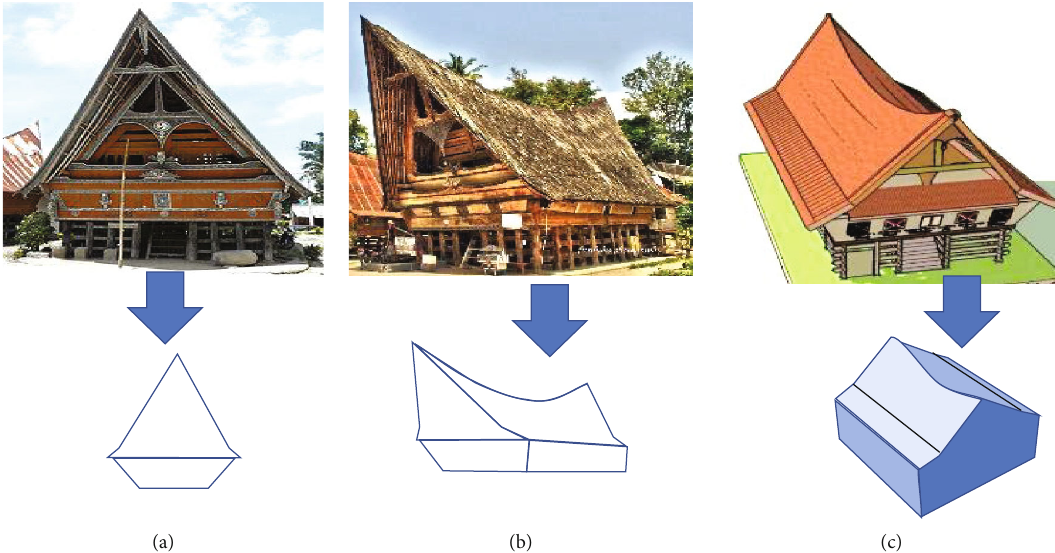
Figure 23: Batak Toba house from three di ff erent vanishing points.